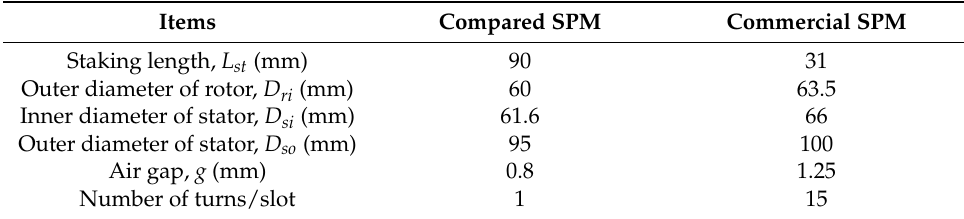
Table 5. Characteristics of the two studied models.